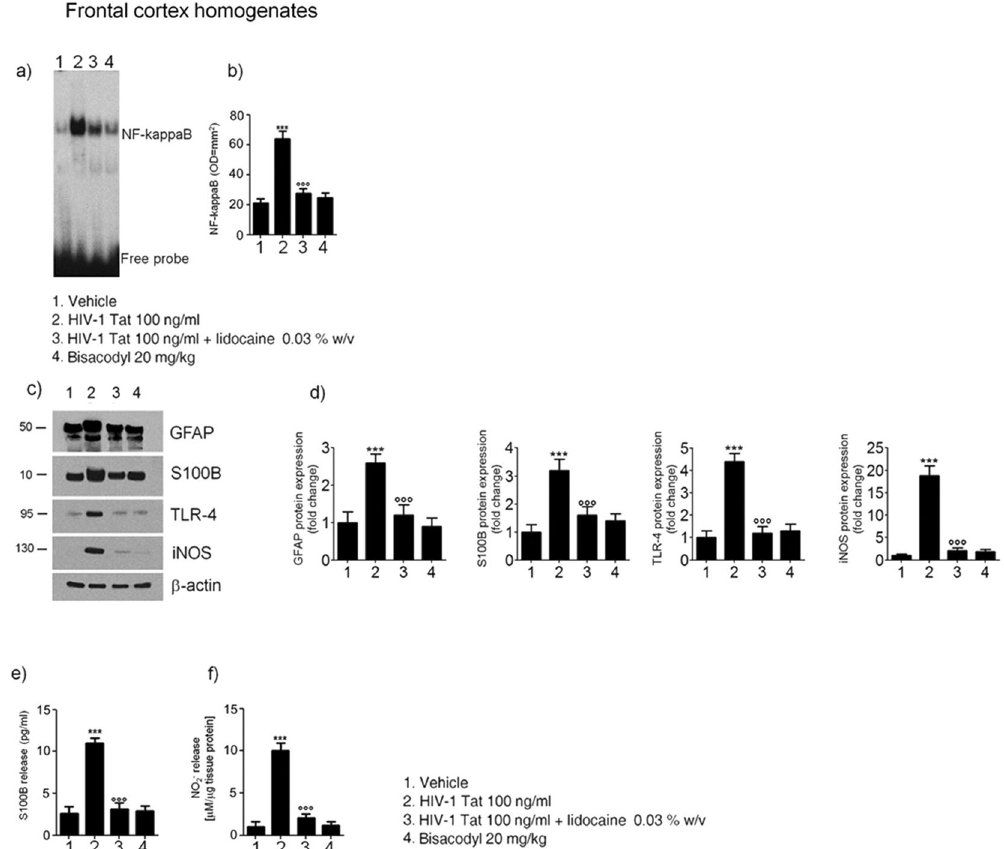
Figure 7. Effect of HIV-1 Tat treatment on NF-kappaB activation in the nuclear extracts of frontal cortex and astrocytes activation. ( a ) The panel shows representative NF-kappaB activation complex bands in the different groups of rats. ( b ) The quantitative analysis revealed that intracolonic HIV-1 Tat administration yields to a significant increase of NF-kappaB, as compared to vehicle, lidocaine, or bisacodyl groups (OD = optical density in mm 2 ). ( c ) HIV-1 Tat caused a marked increase of GFAP, S100B, TLR-4 and iNOS protein expression in the frontal cortex homogenates of treated rats. ( d ) Quantitative analysis reveled that HIV-1 Tat induced a significantly higher expression of GFAP, S100B, TLR-4 and iNOS, than lidocaine, or bisacodyl groups. ( e , f ) In the medium of frontal cortex homogenates deriving from HIV-1 Tat group a significant increase of NO 2 − and S100B was also observed as compared to the other groups. (Results are expressed as mean ± SEM; *** p < 0.001 vs all other groups; °°°p < 0.001 vs HIV-1 Tat group; n = 6 for each